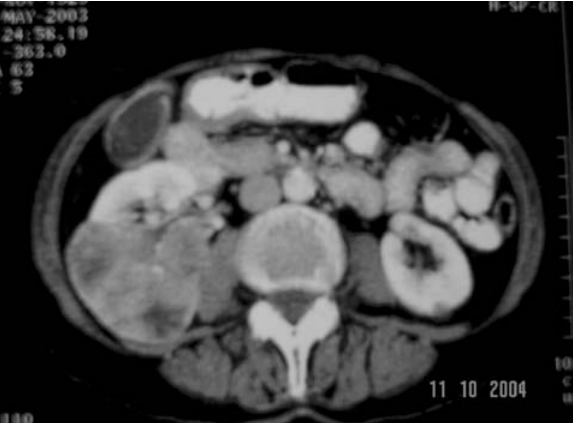
Figure 1 – Computed tomography (CT) of abdomen showing a mass, involving the right kidney almost